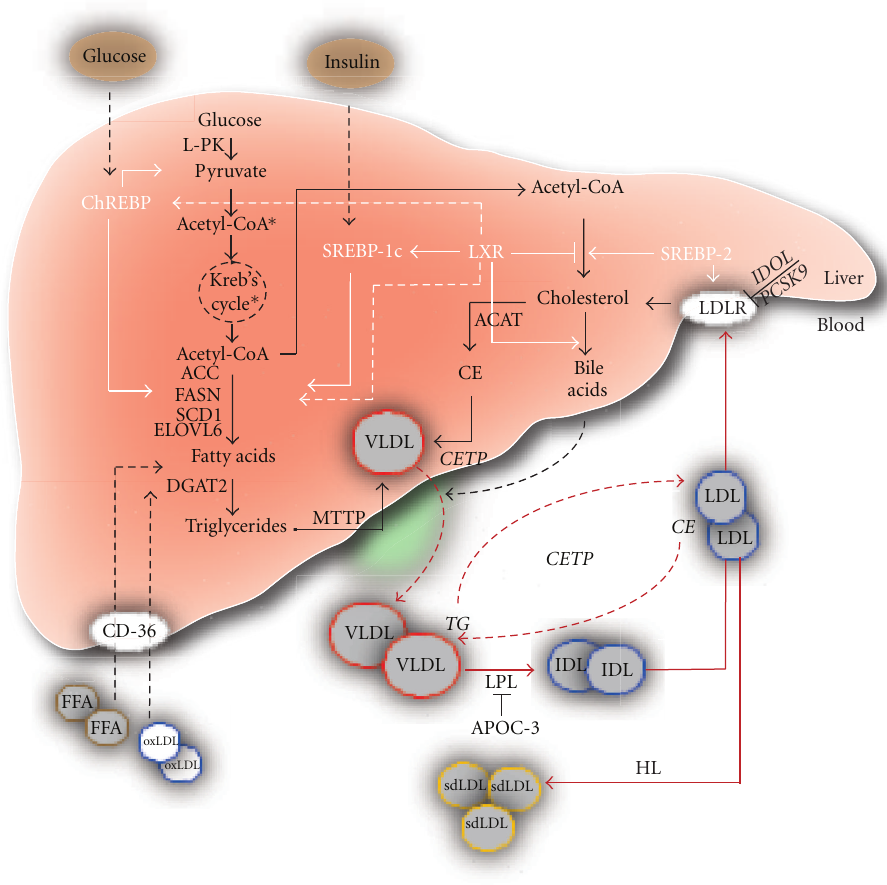
Figure 1: Lipid and lipoprotein pathways in the pathogenesis of NAFLD. NAFLD is considered to be liver manifestation of obesity and metabolic syndrome. In response to insulin and glucose, transcription factors SREBPs and ChREBP are activated and induce the expression of genes involved in the synthesis of fatty acids and cholesterol in the liver. Enhanced lipogenesis leads to enhanced VLDL production, a major metabolic perturbation in NAFLD. Increased VLDL secretion in plasma results in increase in LDL through CETP-mediated exchange of cholesteryl esters and triglycerides between LDL and VLDL, followed by triglyceride removal from LDL by hepatic lipase (HL). Liver removes LDL from circulation by LDLR-mediated endocytosis. Oxidized LDL and FFA are transported to the liver by CD-36, FA translocase, and scavenger receptor. Italics: metabolic genes, black lines: metabolic pathways, black dash lines: coming out or in the liver, white lines: transcriptional regulation, ∗ process in the